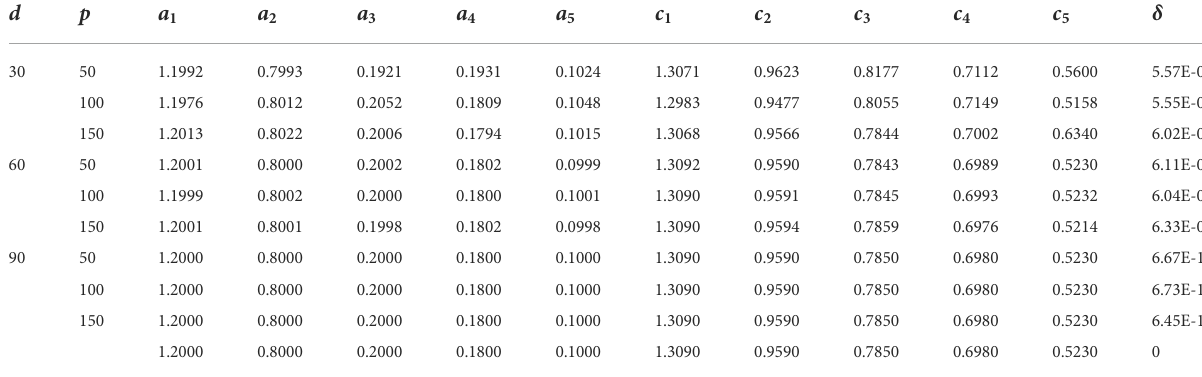
TABLE 8 Results of parameter estimates of Example 2 for G =